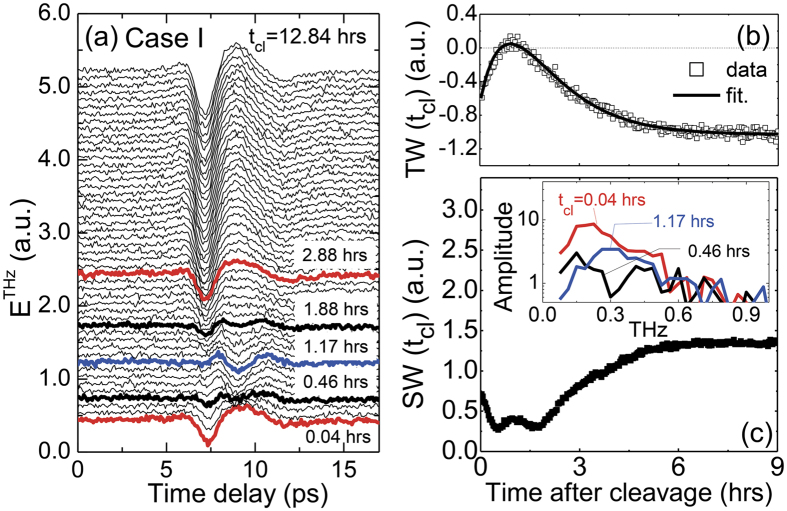
(a) Time(t)-domain electric-field profiles of emitted THz waves ETHz(t) from Bi1.5Sb0.5Te1.7Se1.3 displayed in the chronological order after its cleavage in air (Case I). Five ETHz(t) are highlighted, and they are obtained at tcl = 0.04, 0.46, 1.17, 1.88, and 2.88 hours after the cleavage of the sample in an ambient air. (b) Integrated ETHz(t) between t = 4.5 ps and 7.8 ps given as a function of tcl. (c) Integrated THz wave spectrum ẼTHz(ω) between ω/2π = 0.04 THz and 0.79 THz plotted as a function of tcl. Note that both values in (b,c) are normalized by the values at tcl = 9 hours. Inset shows three representative ẼTHz(ω) obtained from the Fourier transform of ETHz(t).